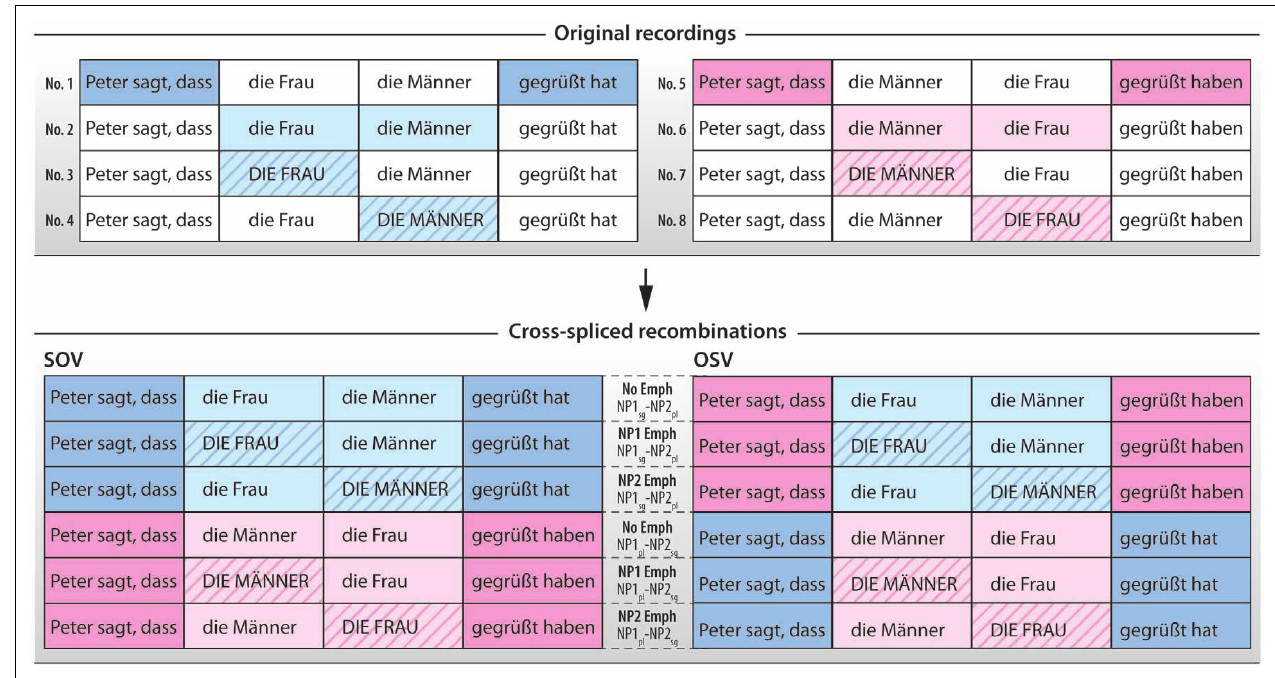
FIGURE 3 | Outline of the cross-splicing procedure for Experiment 2. Noun phrases in CAPITALS indicate those phrases during which the speaker produced a beat gesture during the recording.